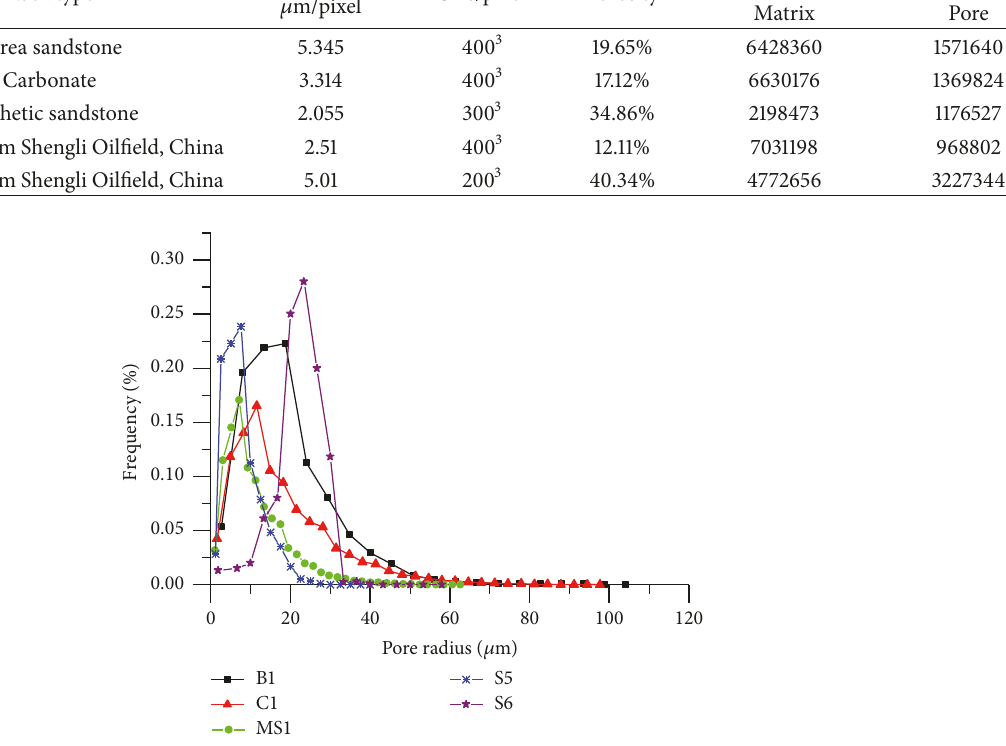
Figure 1: Pore radius distribution of images used in this